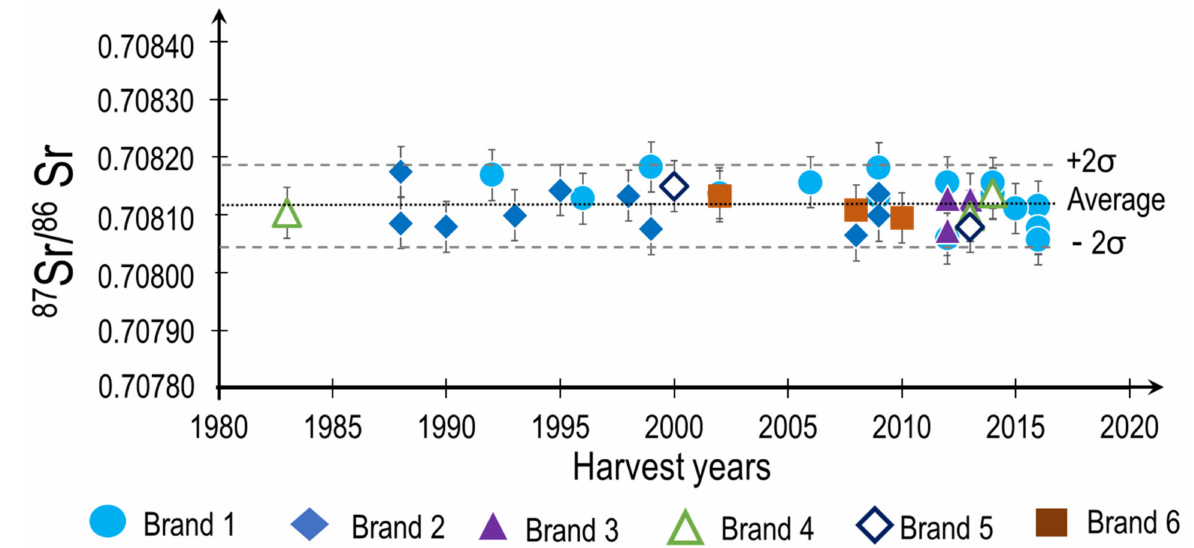
Figure 1. 87 Sr/ 86 Sr as a function of the year of harvest of the 39 Champagnes from six different brands with the average and 2 σ . The error bars (2 σ ) were obtained from a triplicate of the same